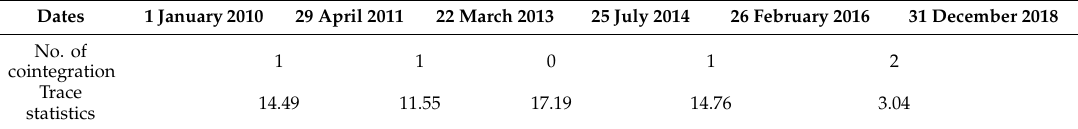
Table 3. Result of cointegration test of US ethylene, crude oil and natural gas